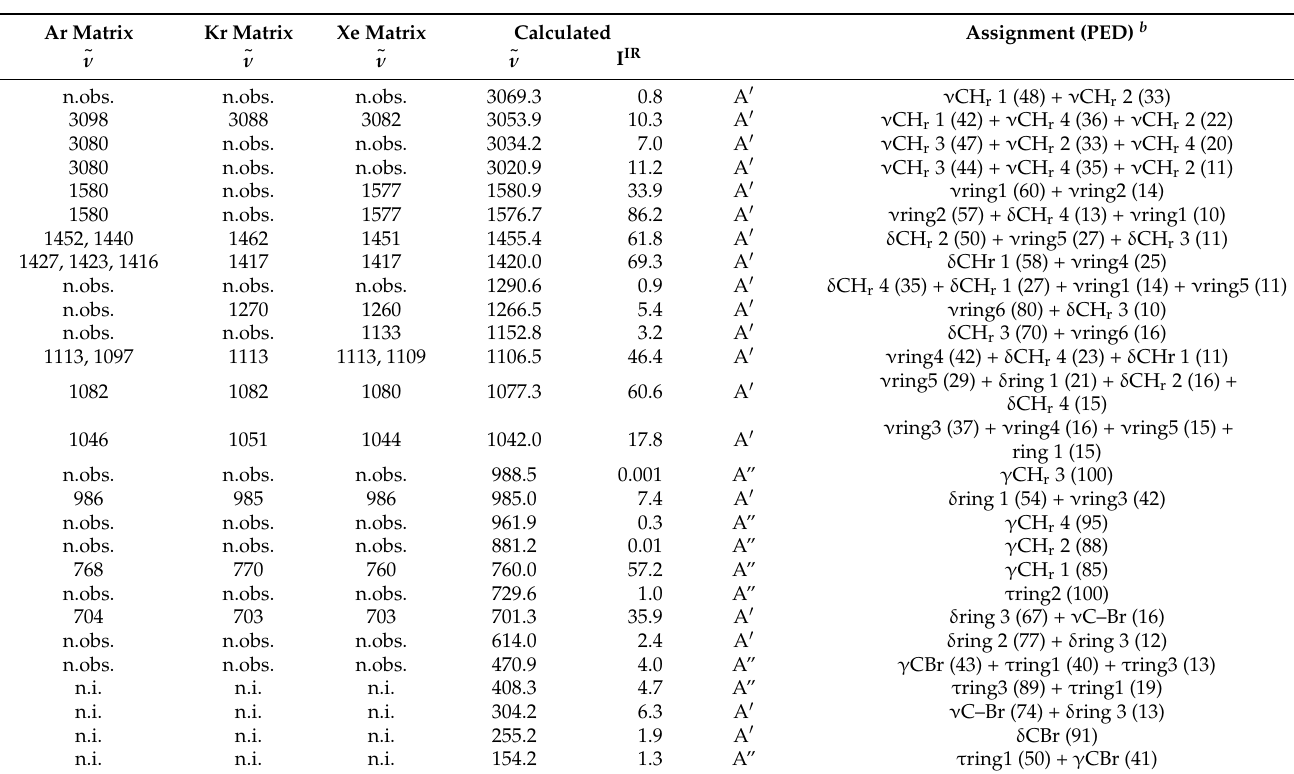
Table 4. Assignment of the IR spectrum of the photoproduced 2-bromopyridine in Ar, Kr and Xe matrices and calculated PEDs a